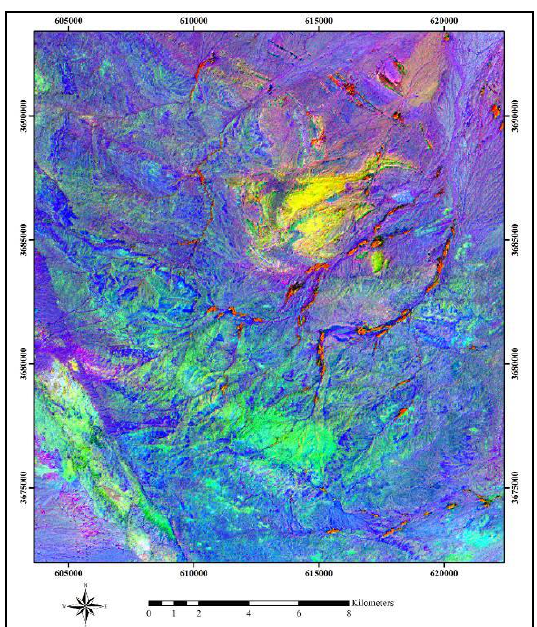
Figure 9. RGB color composite of PC2, PC3 and PC6 images shows how argilic and propylitic alteration zones are distributed in the area. Identified pyrites are related to argillic and propylitic as major minerals in copper deposits